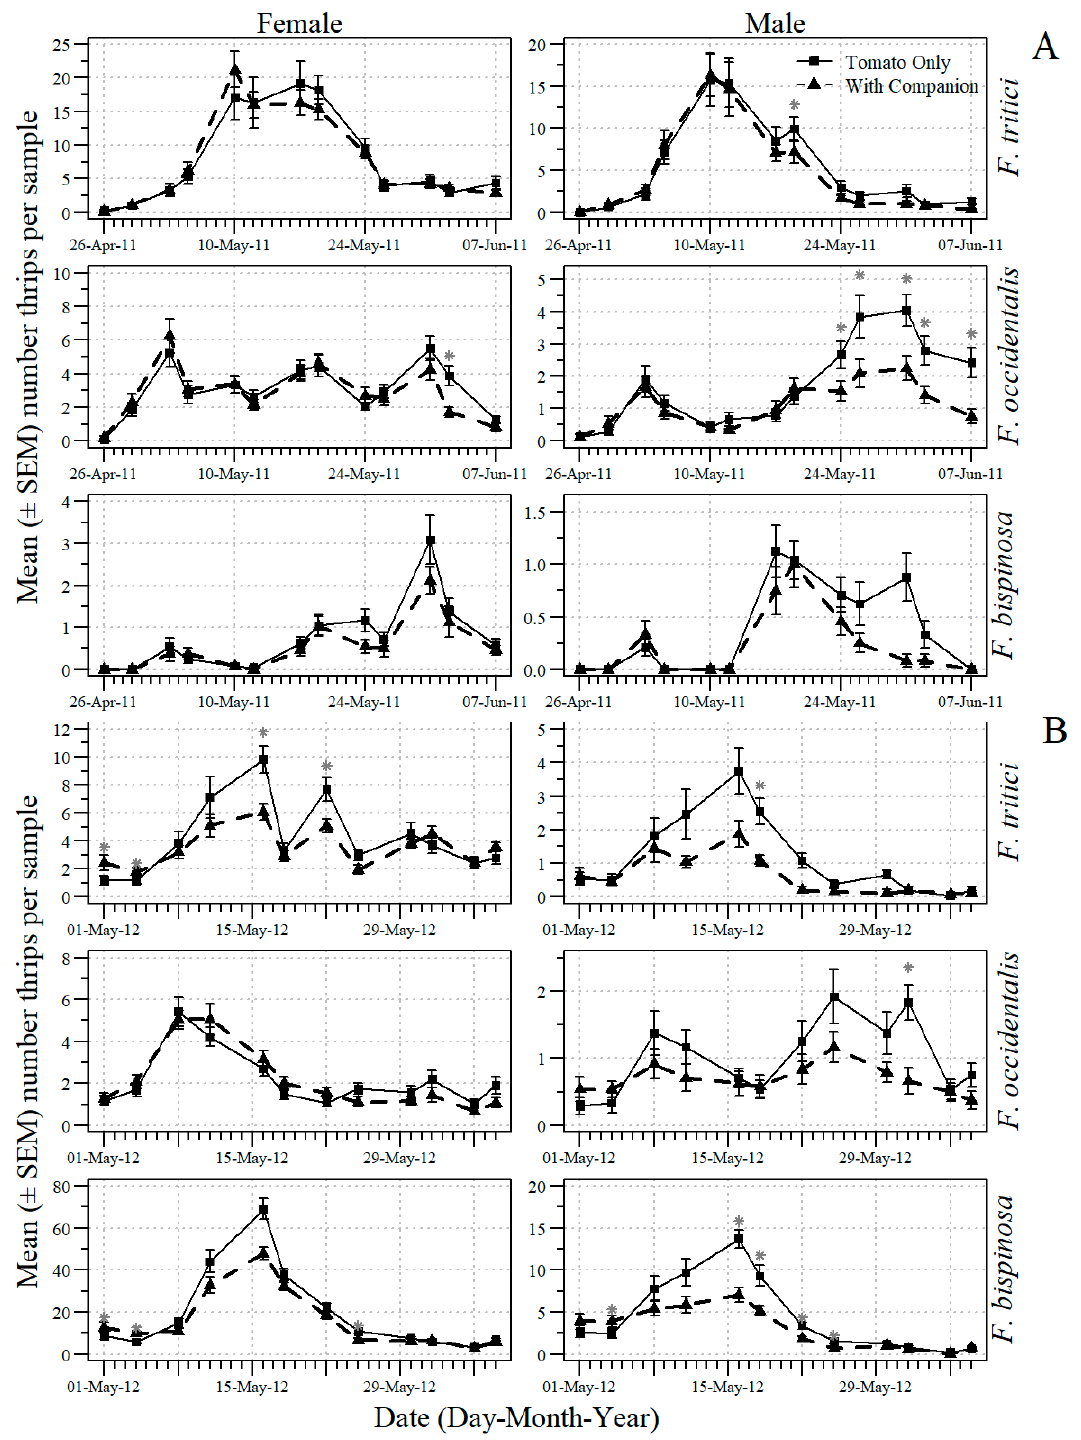
Figure 3. The mean number (+SEM) per 10 tomato flowers (n = 6 samples) of adult male and female F. occidentalis, F. bispinosa and F. tritici on each 2011 ( A ) and 2012 ( B ) sample date in the sub-subplot treatments of no companion plants and companion plants in the experiments conducted in Gadsden County, Florida (* indicates significance beyond 95% level according to analysis of variance conducted for individual sample dates; d. f. = 1, 8).